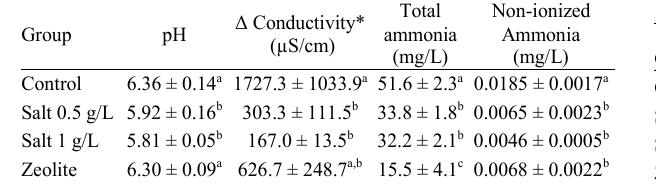
Table 1. Water parameters at the end of transport (48h) of Ancistrus triradiatus in plastic bags. *  Conductivity represents the increase in conductivity between the beginning and end of transport. Data are expressed as mean ± standard deviation. Different letters indicate significant differences between groups.